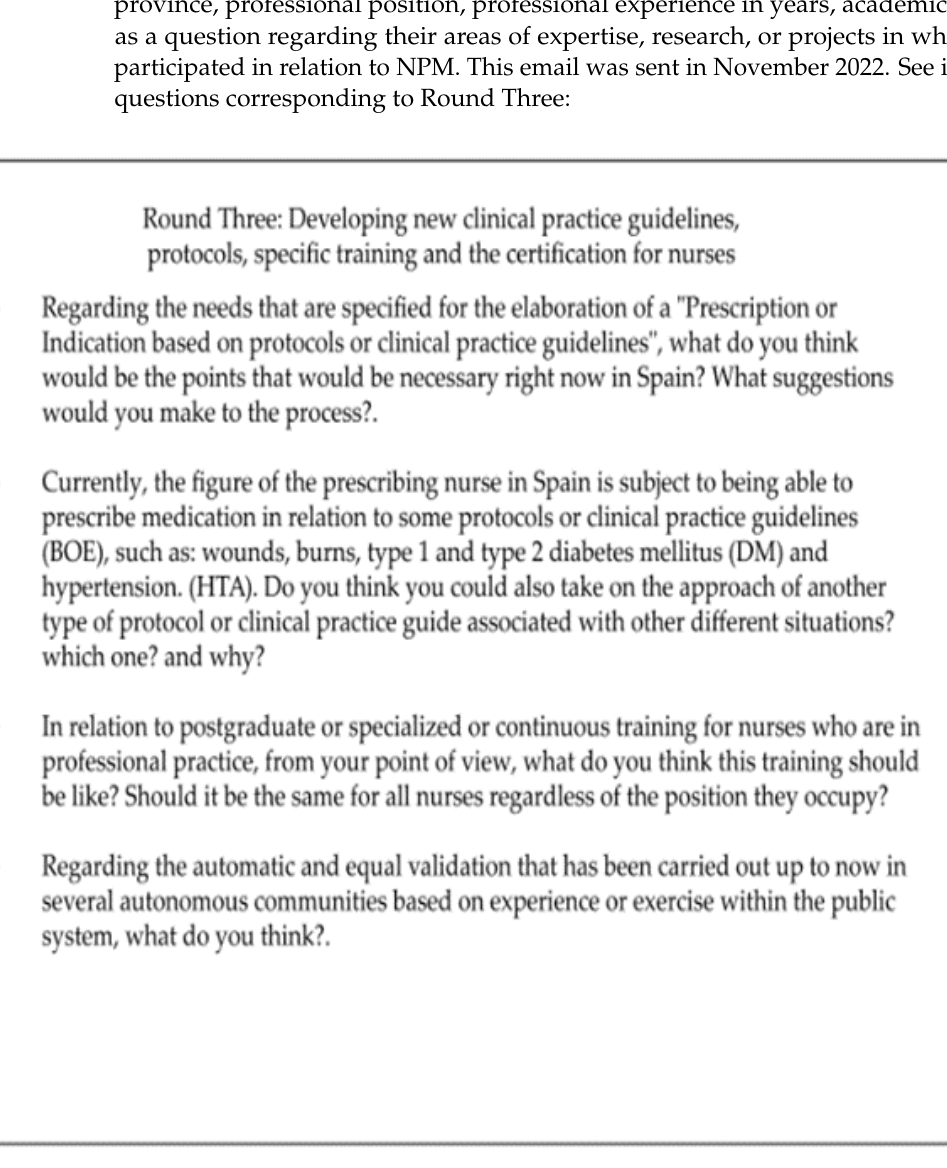
Figure 3. Round Three: Developing new clinical practice guidelines, protocols, specific trainings and the certification for nurses.